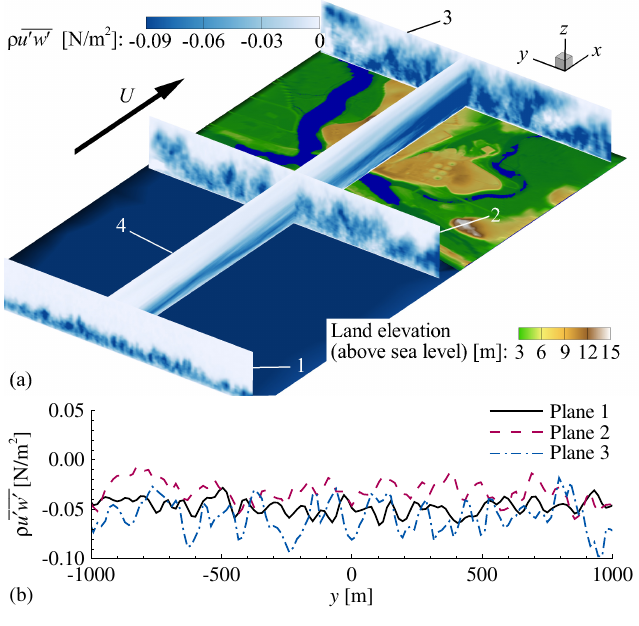
Figure 4. Time-averaged turbulent momentum flux ρ u (cid:48) w (cid:48) in case ESB1. ( a ) Contours at three y – z planes and one x – z plane, and ( b ) spanwise profiles at z = 50 m at planes 1, 2, and